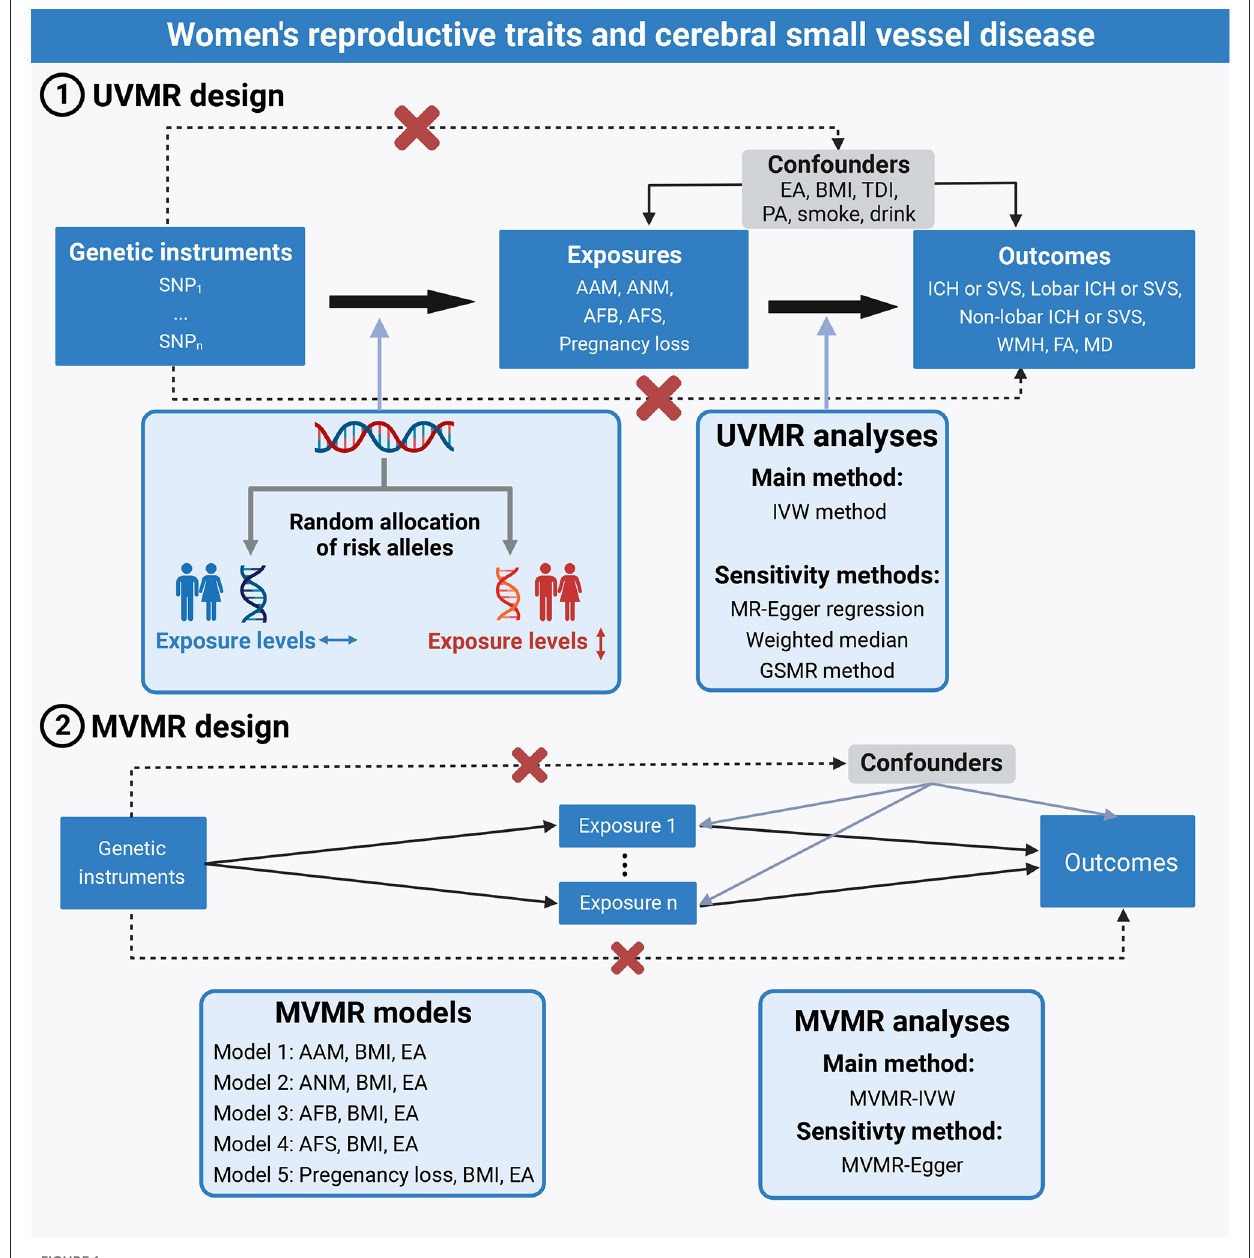
FIGURE1 Assumptions and study design of the MR study of the associations between 5 women’s reproductive traits and CSVD. AAM, age at menarche; AFB, age at first birth; AFS, age at first sexual intercourse; ANM, age at natural menopause; BMI, body mass index; CSVD, cerebral small-vessel disease; EA, educational attainment; GSMR, generalized summary-data-based Mendelian randomization; ICH, intracerebral hemorrhage; IVW, inverse-variance weighted; MVMR, multivariable Mendelian randomization; PA, physical activity; SVS, small-vessel ischemic stroke; TDI, Townsend deprivation index; UVMR, univariable Mendelian